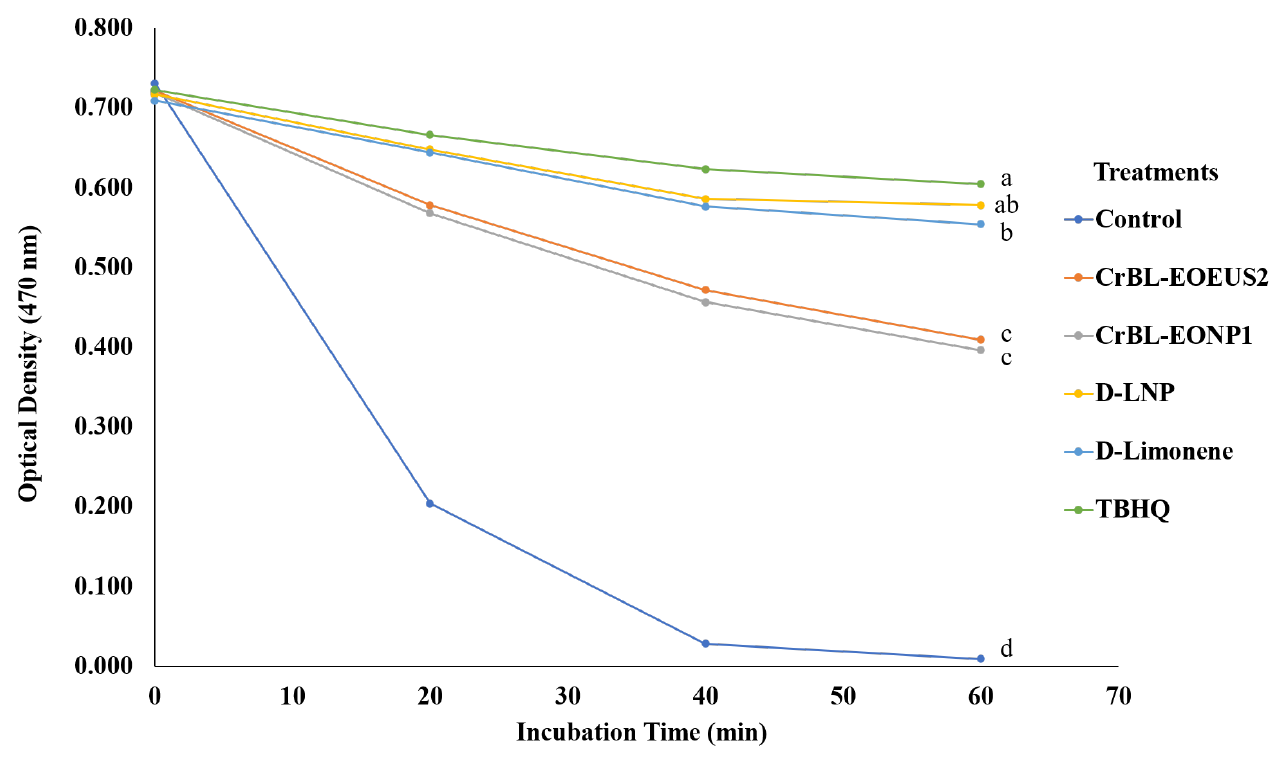
Figure 6. The bleaching rate curves (at an optical density of 470 nm) of the β -carotene color in the coupled system of β -CLE in the presence of the essential oil of C. reticulata with pre-enzymolysis and ultrasound–microwave treatment (CrBL-EO EUS2 ), C. reticulata essential oil nanoemulsion (CrBL- EONE), D-limonene nanoemulsion (D-LNE), D-limonene, and TBHQ. Lines with the same lowercase letters indicate no significant differences in treatment at the final incubation time (60 min).